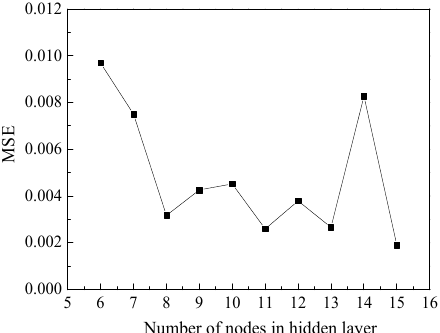
Figure 8. MSE of network with different numbers of notes in the hidden layer.